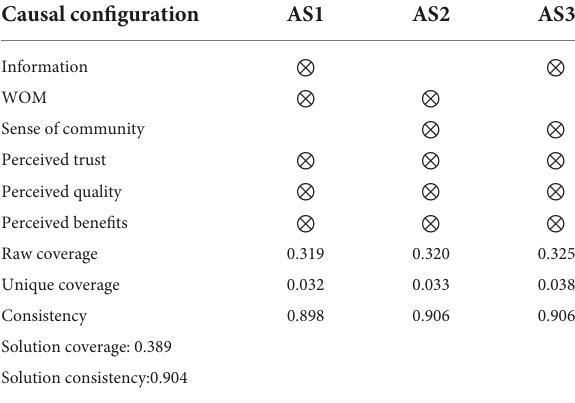
TABLE 5 Configurations for the Absence of the outcome conditions (fsQCA). Causal